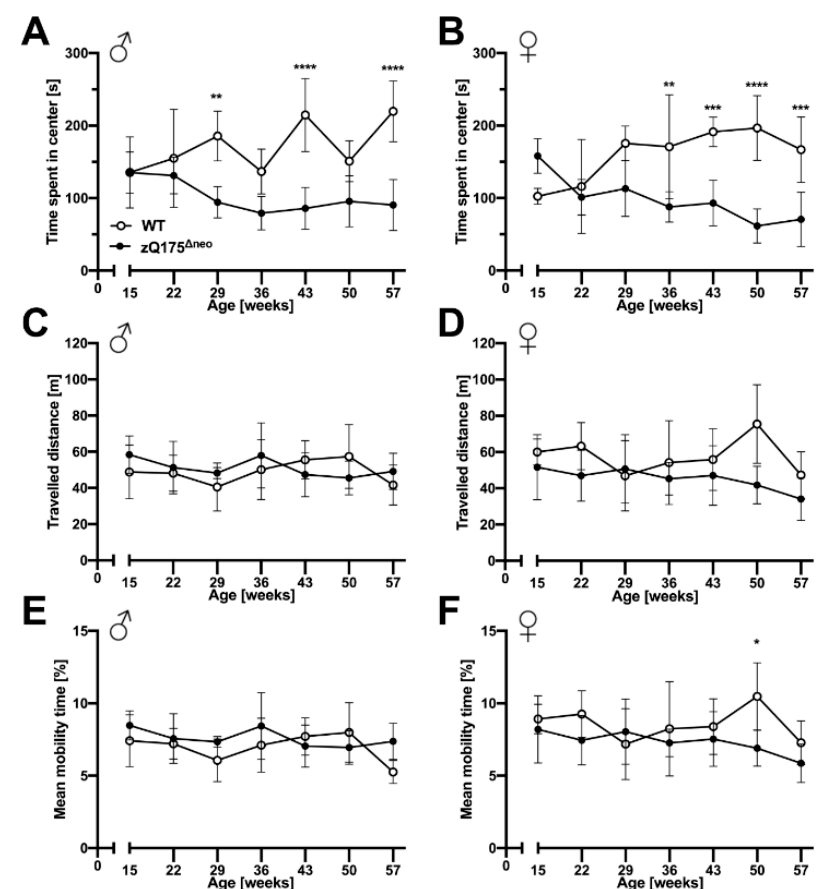
Figure 6. zQ175 Δ neo mice displayed anxiety-like behavior. The explorative behavior of male ( A , C , E ) and female ( B , D , F ) WT ( ○ ) and zQ175 Δ neo mice ( ● ) was evaluated with the open field test assessing and female ( B , D , F ) WT ( the time spent in the center ( A , B ), travelled distance ( C , D ), as well as mean mobility ( E , F ). Data are presented as mean ± SD; N = 4–6. Significance was calculated using two-way ANOVA with Bonfer- roni’s multiple comparisons test and is given as *: p ≤ 0.05, **: p ≤ 0.01, ***: p ≤ 0.001, and ****: p ≤ 0.0001.